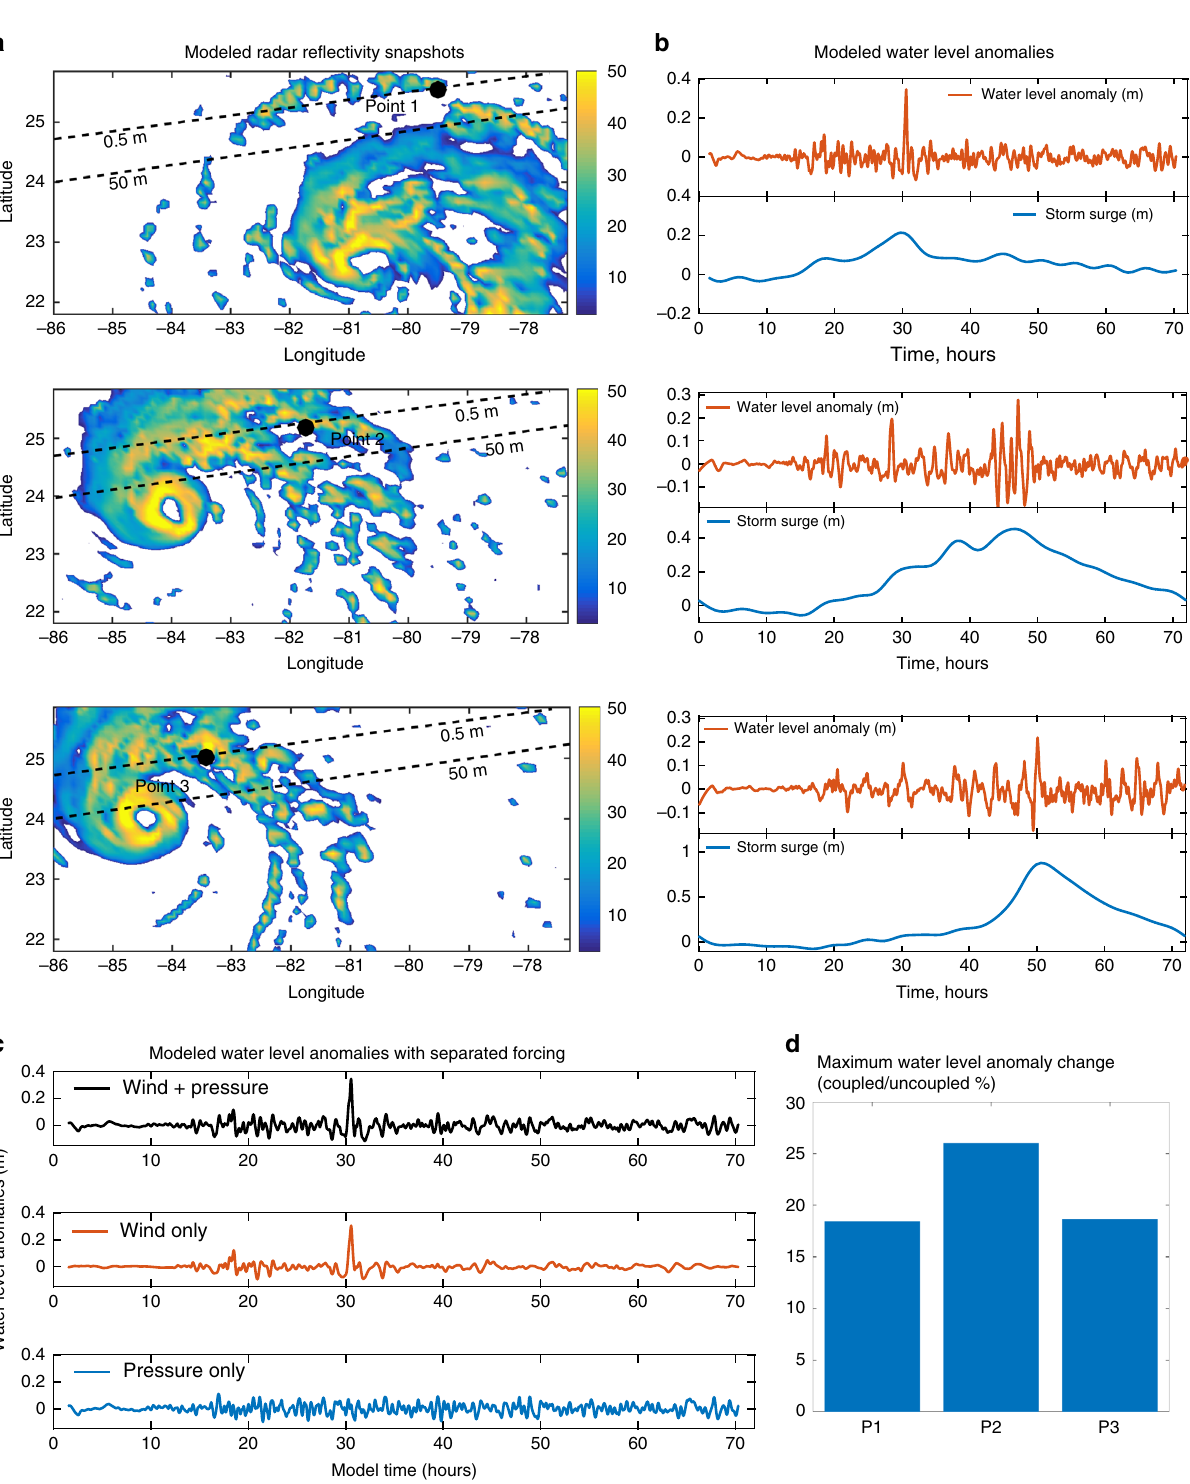
Fig. 6 Meteotsunami waves triggered by an idealized tropical cyclone. a Modeled atmospheric radar re fl ectivity snapshots of the idealized tropical cyclone, where radar re fl ectivity is given in dBZ (decibel relative to Z); the thick dash lines represent the 0.5 and 50 m isobaths; the fi gure also depicts the location of the coastal points (Point 1, Point 2, and Point 3) used to analyze the water level anomalies. b Time-series of modeled water levels at Point 1, Point 2, and Point 3; c Modeled water level anomalies with wind and pressure forcing (upper panel), with only wind forcing (middle panel) and with only pressure forcing (bottom panel); d Effects of wave-dependent ocean surface roughness indicated by maximum change (in percentage) of water level anomaly between coupled and uncoupled model